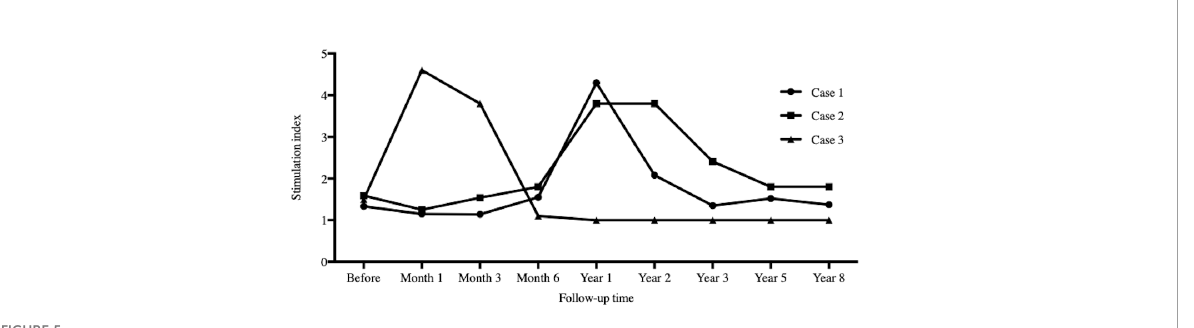
FIGURE 5 Stimulation index. The time points for serial stimulation index records were I , 3, 6, 12, 24, 36, 60 and 96 months after infusion. All three recipients showed low level of stimulation index during the